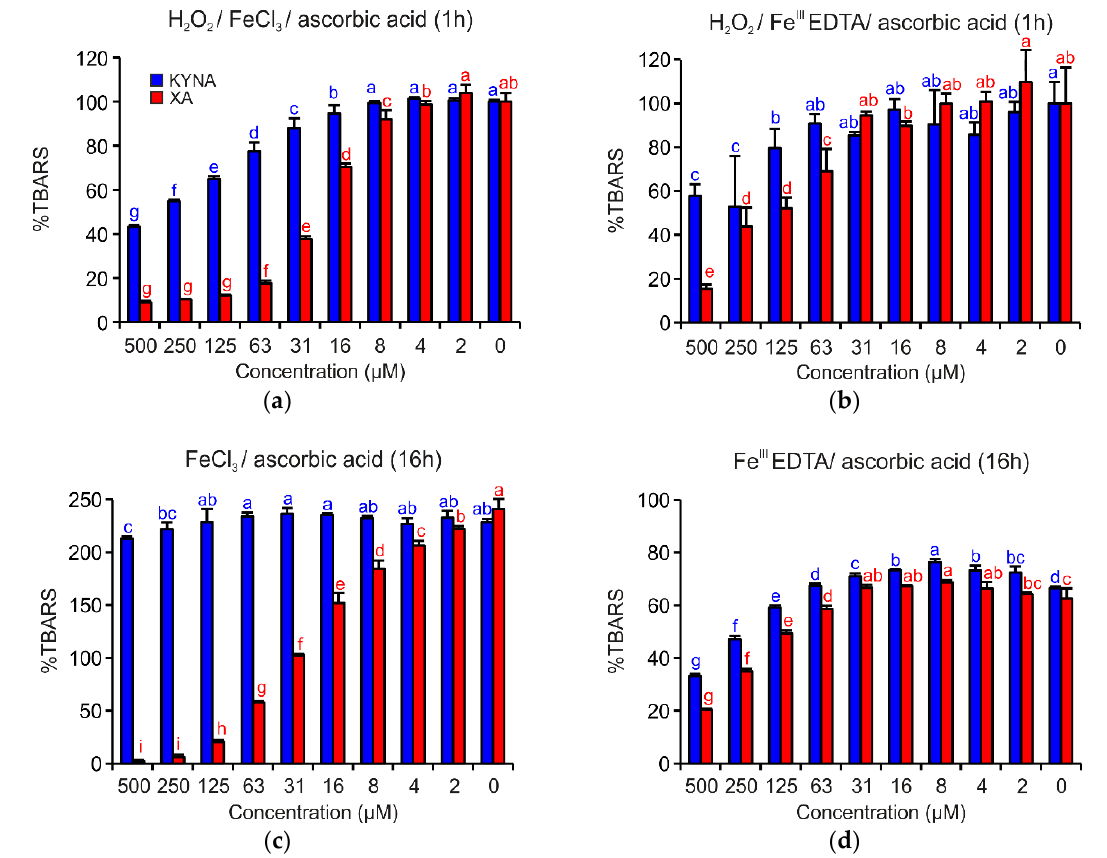
Figure 4. Inhibition effects of KYNA or XA on TBARS formation in the deoxyribose degradation assay: ( a ) H 2 O 2 /FeCl 3 /ascorbic acid, ( b ) H 2 O 2 /Fe III EDTA/ascorbic acid, ( c ) FeCl 3 /ascorbic acid and ( d ) Fe III EDTA/ascorbic acid. The bars represent the mean of three replications (± S.D.). Letters above the bars indicate significance levels (ANOVA with 95% Duncan’s post hoc test). TBARS: thiobarbituric acid reactive species, S.D.: standard deviation.